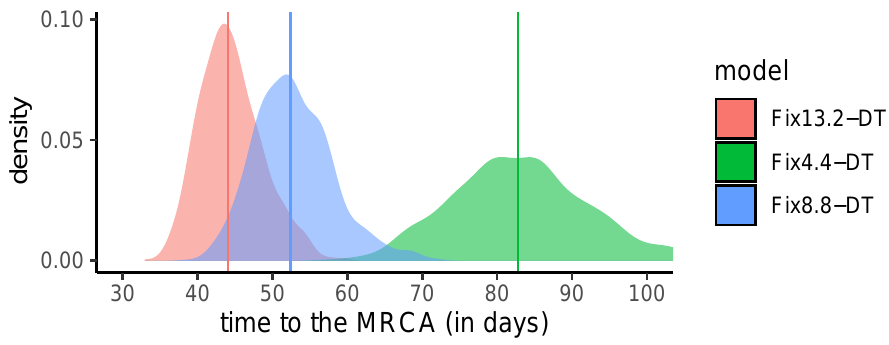
Figure 2 – Time to the origin of the French epidemic wave as a function of the molec- ular clock. This estimate was obtained assuming an exponential growth coalescent pop- ulation model and a fixed molecular clock (see Figure S4 for the BDSKY model). Colors indicate substitution rates and numbers (4.4, 8.8, 13.4) refer values to be multiplied by 10 − 4 subsitutions/site/year. The slower the clock rate, the further away in time the most recent common ancestor (MRCA). Vertical lines show the distribution medians. The most recent sample dates from Mar 24,